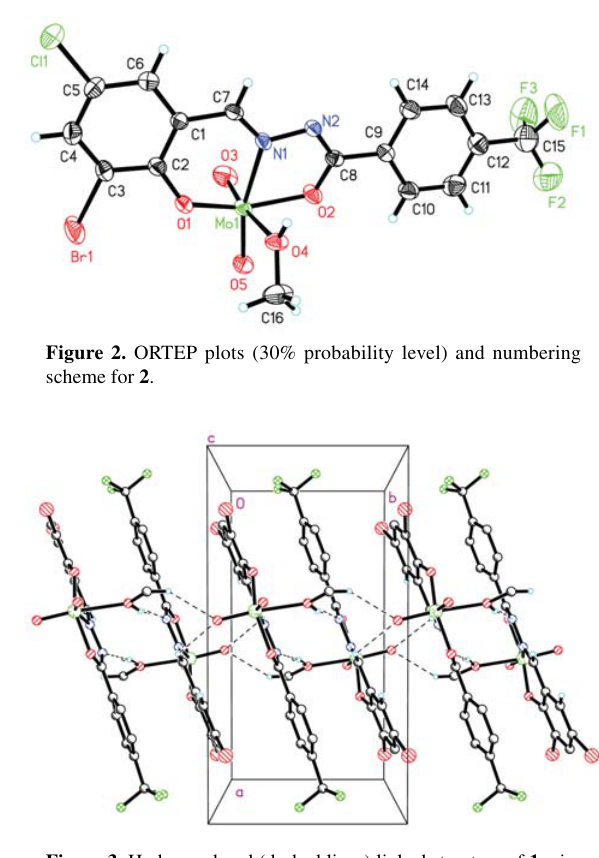
wed down the c axis.